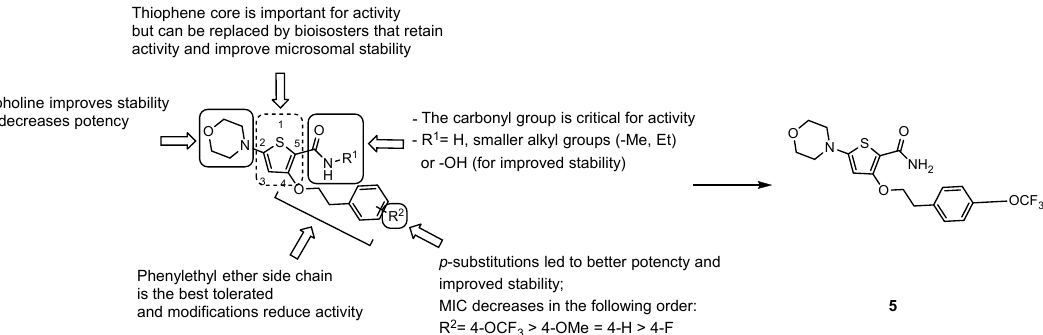
Figure 10. SARs of morpholino-thiophenes and the chemical structure of compound 5.